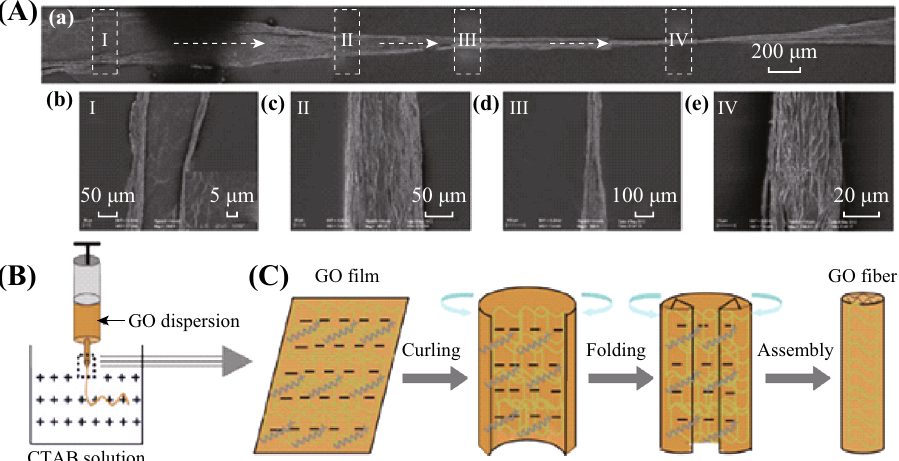
Fig. 10 A SEM images illustrating the assembly process of the GO fiber. Schematic illustration of the apparatus B and assembly mechanism C of wet-spinning GO fibers. Reproduced with permission from Ref. [52]. Copyright 2012, Nature Publishing